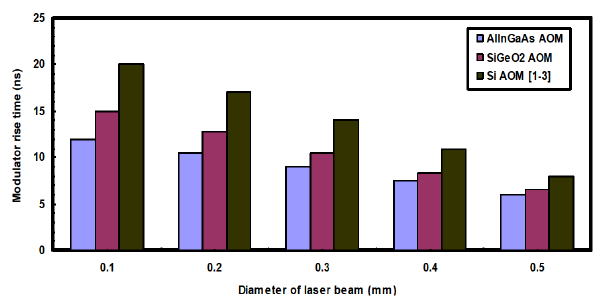
Figure 3: Variations in modulator frequency response in relation to laser beam diameter for the previous and the proposed AOMs at room temperature